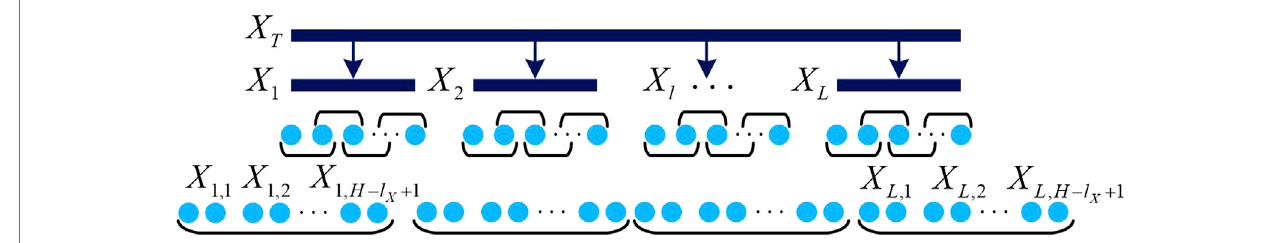
FIGURE 4 | Structure of resampling ship-load subsets with MBB.